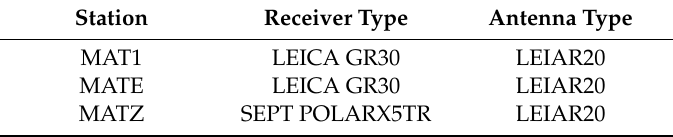
Table 3. Stations selected for the investigation of ISB characterization a ff ected by the receiver